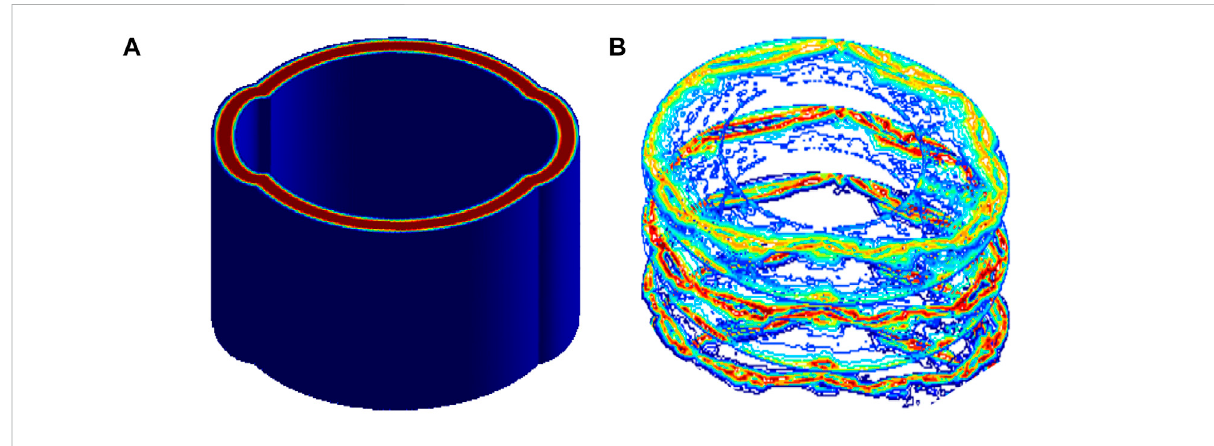
FIGURE 12 Comparison of three-dimensional reconstruction between this method and single array element method. (A) Three-dimensional morphology image. (B) Single array metadata